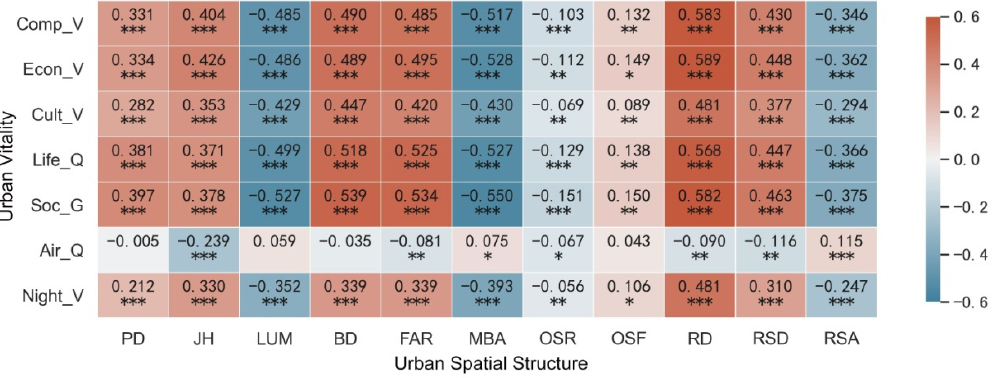
Figure 5. The examples of urban spatial structure indicators and urban vitality indicators.